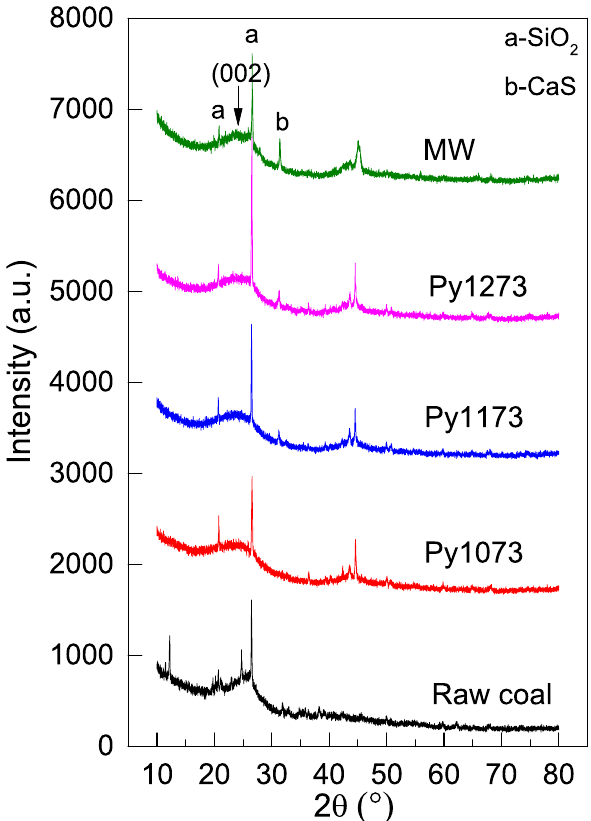
Fig. 1 XRD patterns from raw coal and pyrolyzed chars after conventional and microwave